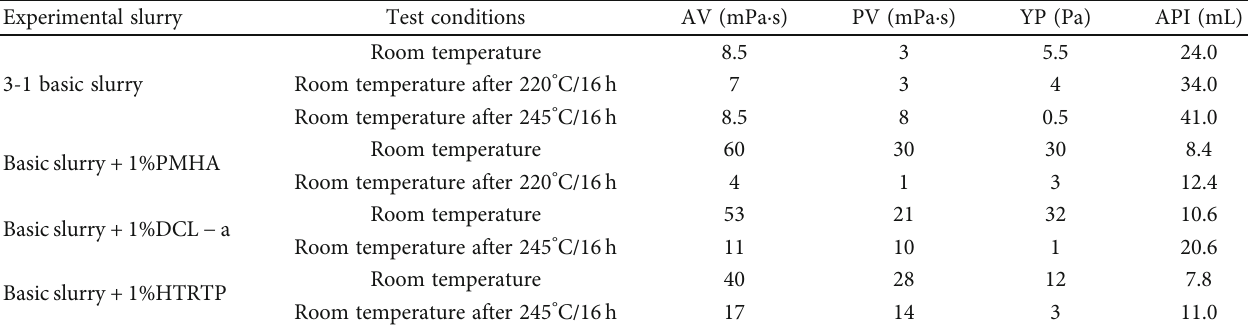
Table 5: Comparison of fl uid loss controlling of fl uid loss agents in fresh water slurry.